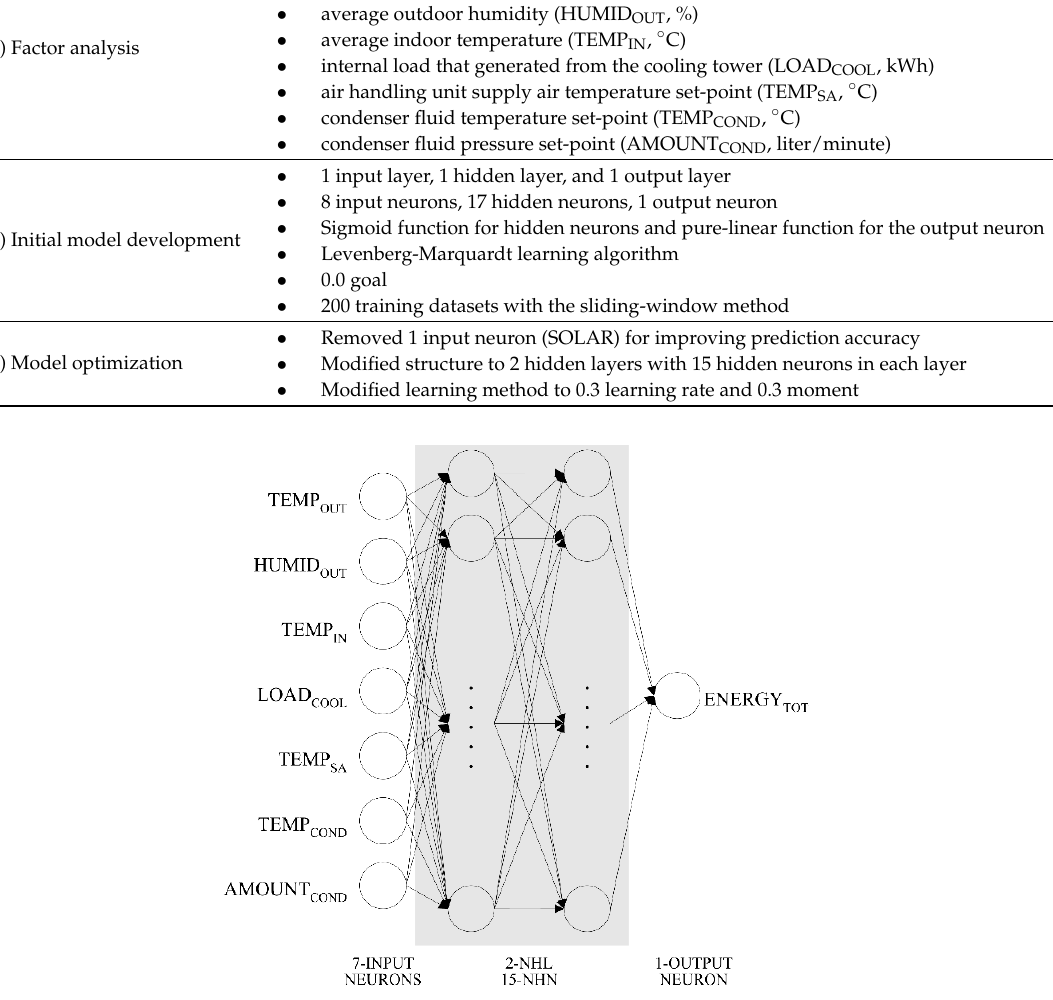
Figure 4. Structure of the optimized ANN model [15].